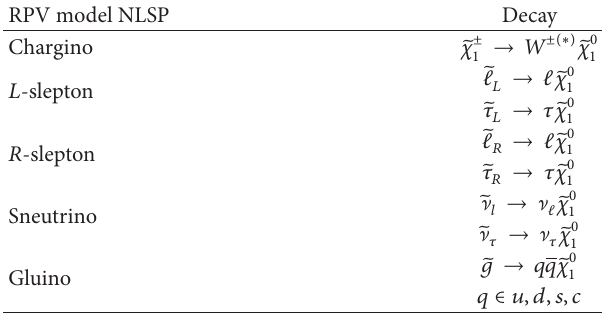
Table 5: Sparticle decays in the SUSY RPV simplified models considered in [40]. The neutralino LSP is assumed to decay to two charged leptons and a neutrino. For the chargino model, the 𝑊 ± from the ̃𝜒 ± 1 decay may be virtual as indicated by the superscript ( ∗